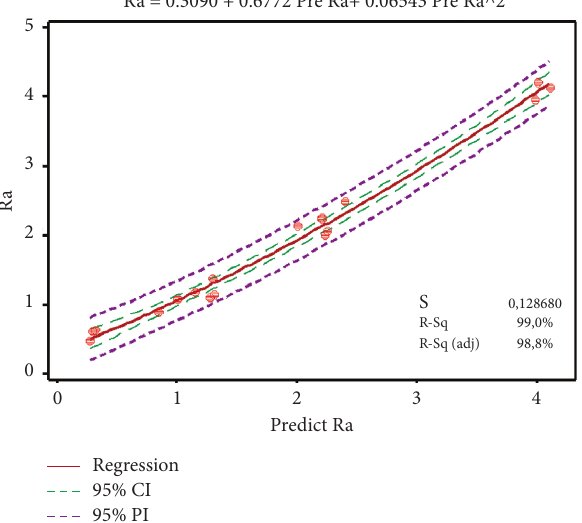
Figure 5: SEM images of the cutting tools.